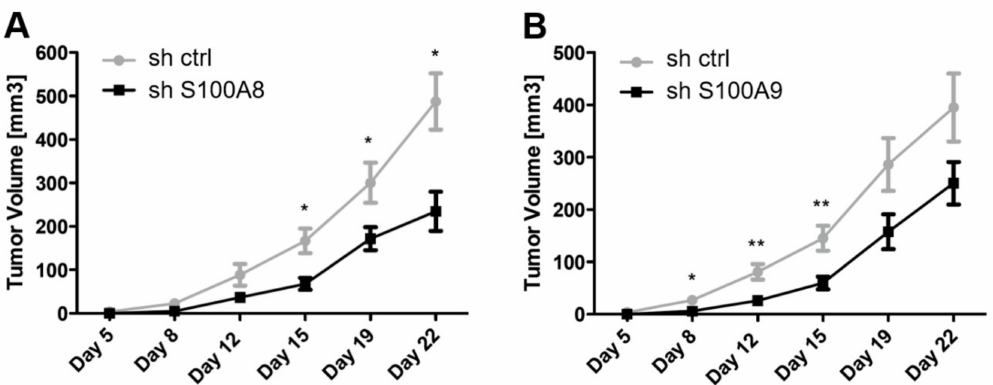
Figure 6. Inhibition of S100A8 and S100A9 in pancreatic cancer cell line L3.6sl reduces in vivo tumor growth. L3.6sl pancreatic cancer cells transduced with non-target control shRNA (sh ctrl) or with sh S100A8 ( A ) or sh S100A9 ( B ) were injected subcutaneously into immune-incompetent mice, and tumor growth was monitored over a period of 22 days. Error bars represent standard error of the mean. Statistical significances were assessed by a two-way ANOVA followed by a Dunnett’s post hoc test (* for p ≤ 0.05, ** for p ≤ 0.01, and *** for p ≤ 0.001, n =